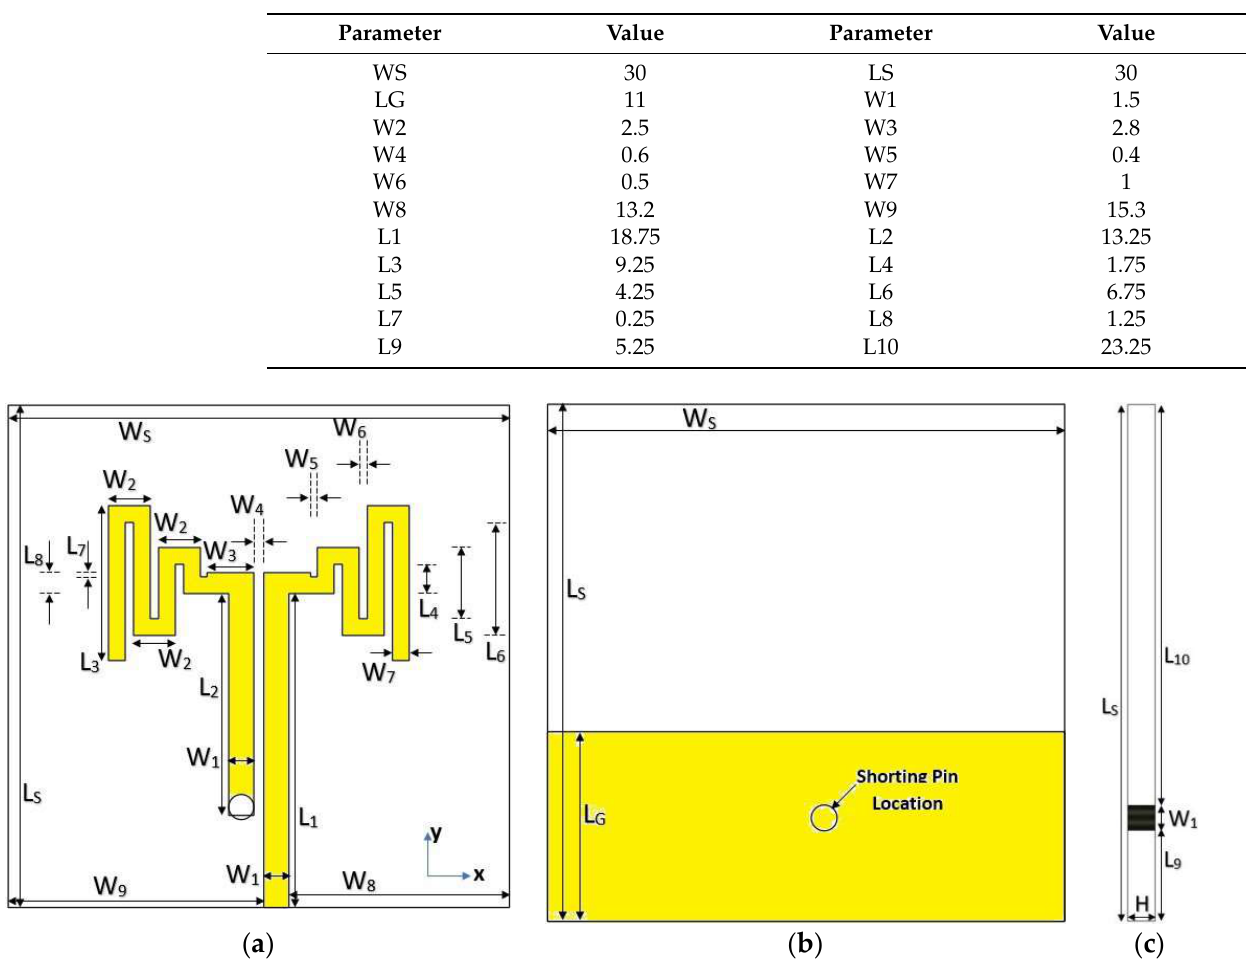
Figure 1. The suggested antenna; ( a ) front view, ( b ) back view, and ( c ) side view. Table 1. Suggested Antenna Lengths in